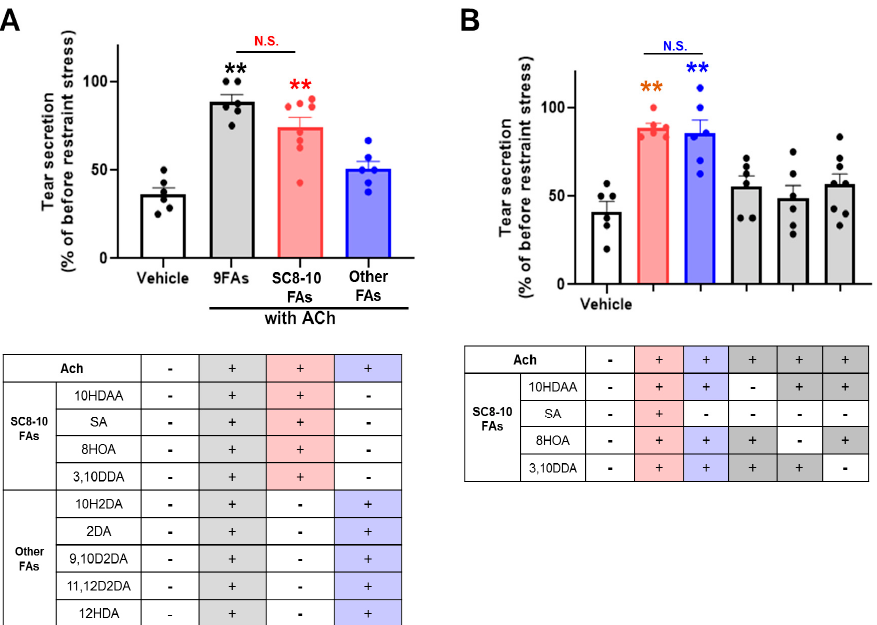
Figure 2. ACh with 10HDAA/8HOA/3,10DDA were the essential components for the anti-dry-eye effect of RJ. ( A ) Effect of saturated C8-10 chains fatty acids (SC8-10 FAs) and the other fatty acids (other FAs) on tear secretion (upper). ( B ) Effect of SC8-10 FAs on tear secretion. All data represent the mean ± SEM, n = 6 mice eyes. ** p < 0.01 versus vehicle. N.S. indicates no significant difference.